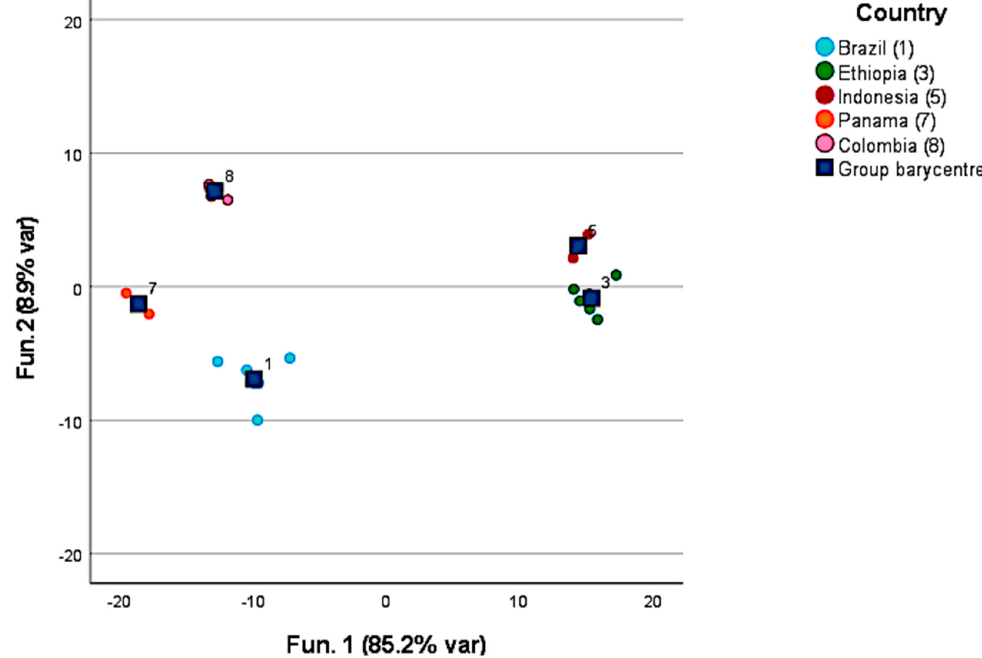
Figure 1. Discrimination of green coffee samples by the countries of origin.